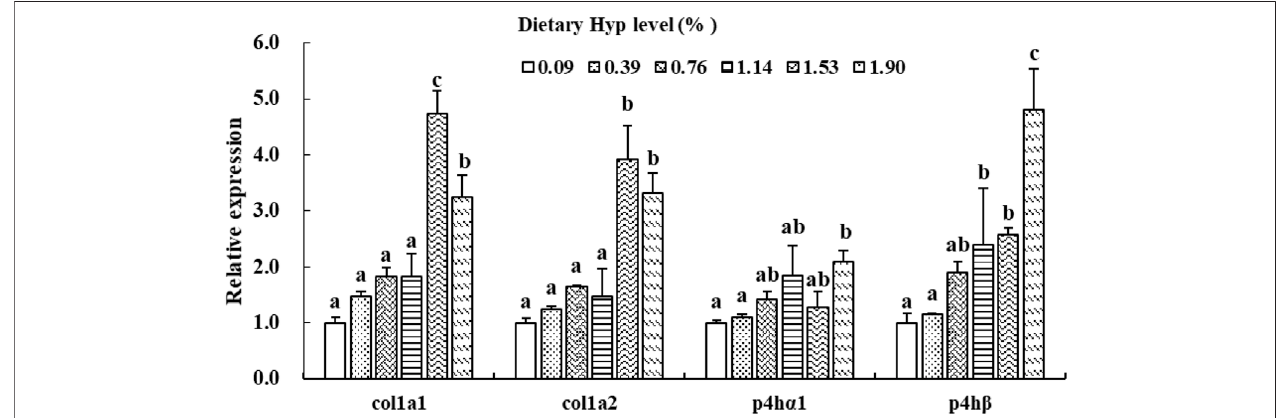
FIGURE 3 | Relative expressions of col1a1 , col1a2 , p4h α 1 and p4h β in muscle of ITCC fed with different experimental diets for 8 weeks. Data are present as Means ± SE (n = 6). Different lowercase letters above the same group of bars represent signi fi cant difference between the corresponding groups ( p < 0.05).